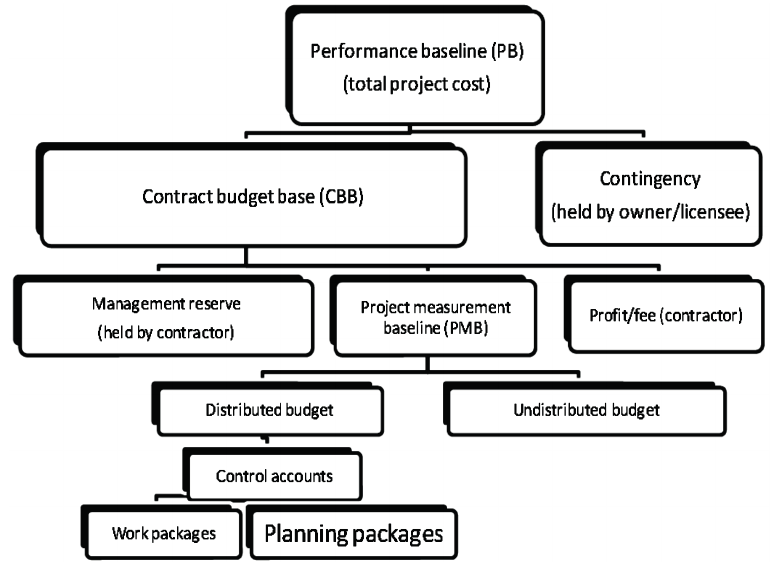
Fig. 11. Performance baseline components (OECD-NEA, 2013: